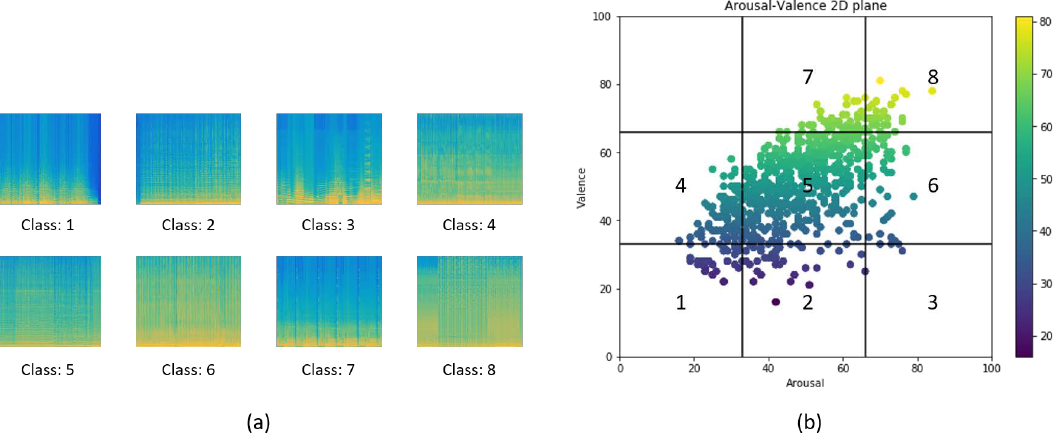
Figure 5. ( a ) Sample images from each class, ( b ) the scatter plot for arousal vs. valence domain values.